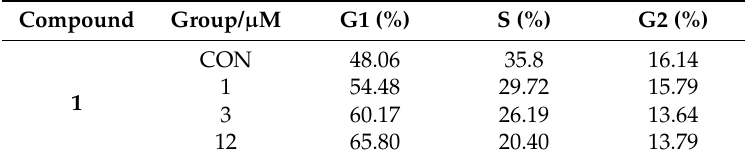
Table 2. Compound 1 effect on cell cycle of HepG2 cells (x ± s, n = 7).